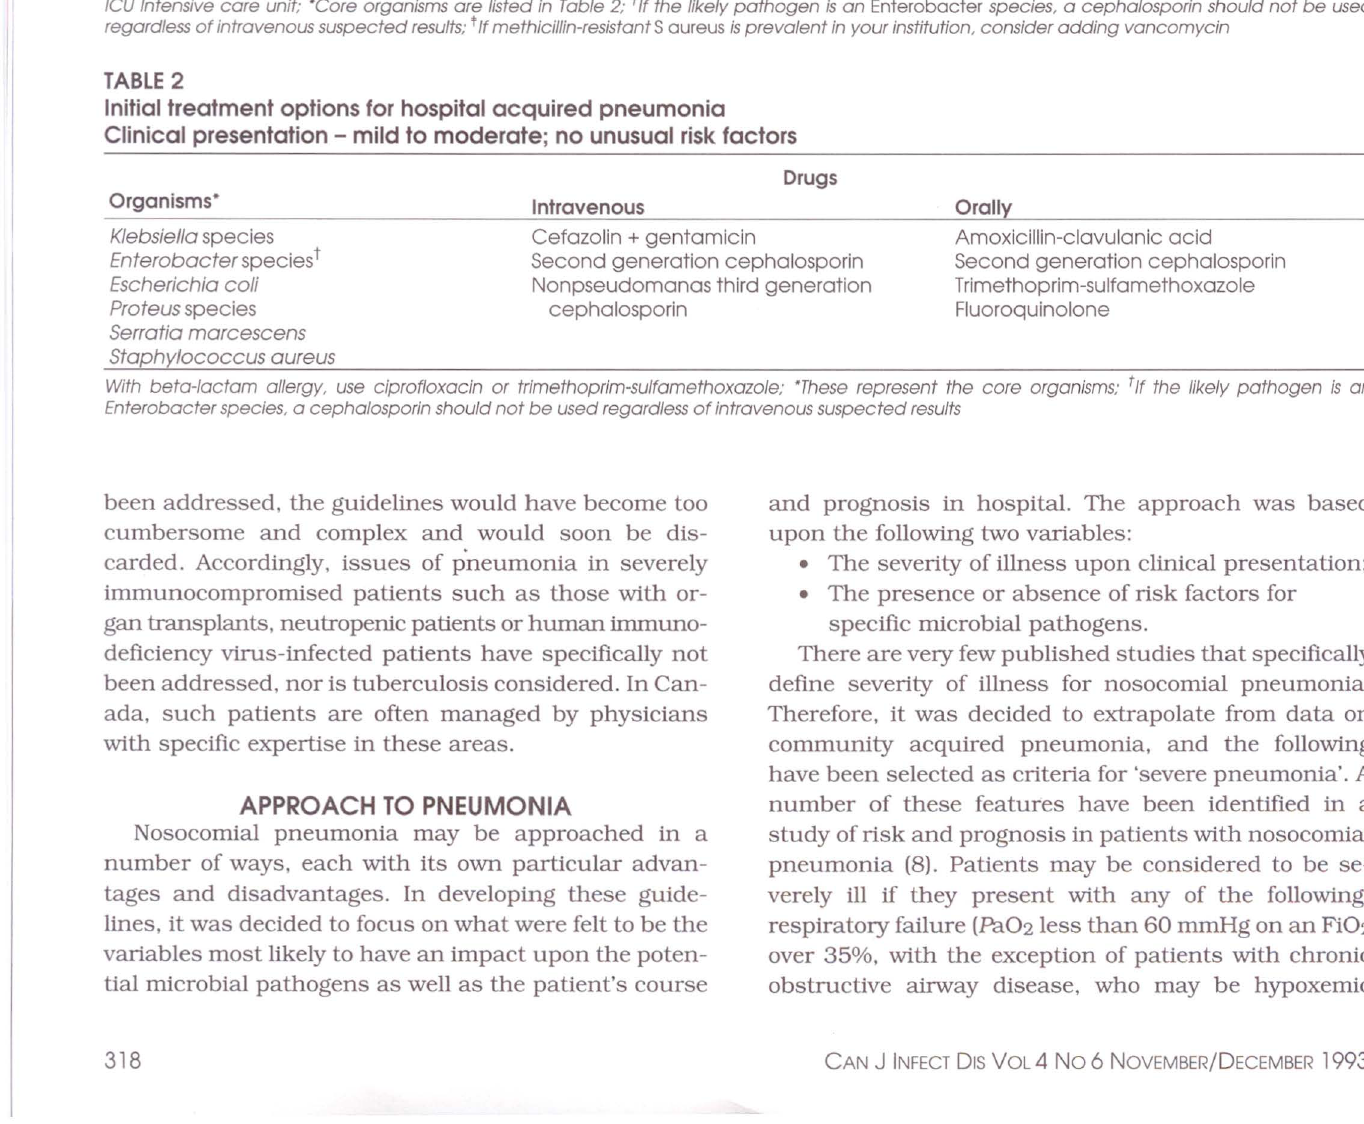
Prior antibiotics and/or